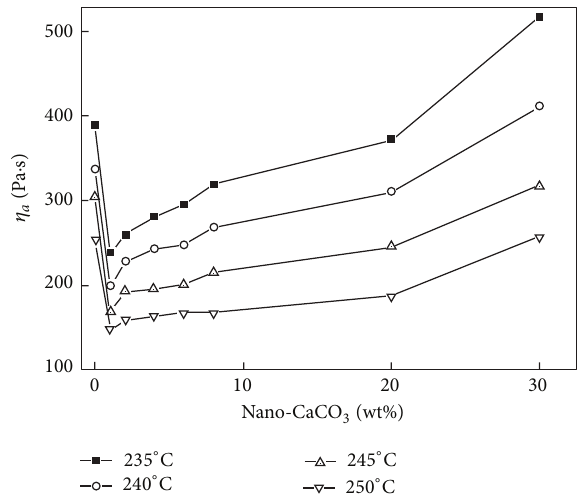
Figure 4: Relationship between 𝜂 𝑎 and CaCO 3 wt% in nanocom- posites at different temperatures.